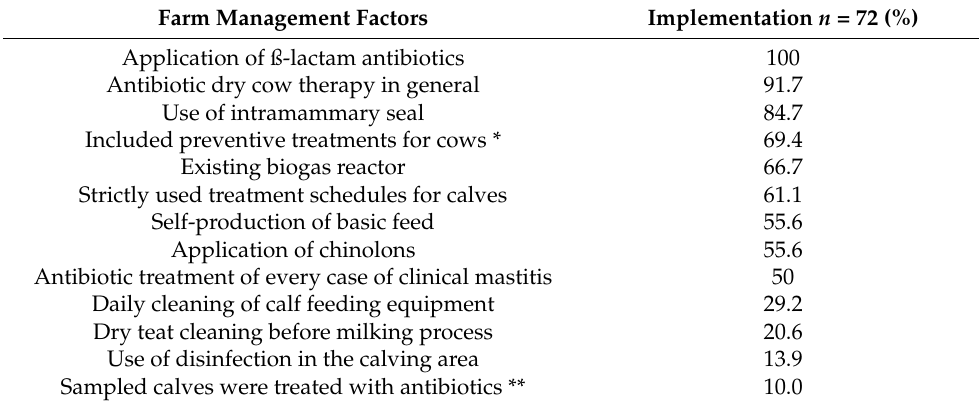
Table 2. Percentage of farms implementing the studied farm management practices.